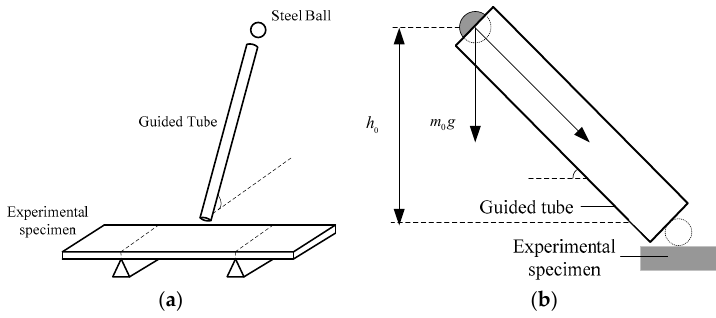
Figure 4. ( a ) Set-up for the generation of the excitation; and ( b ) left-view of the excitation system.